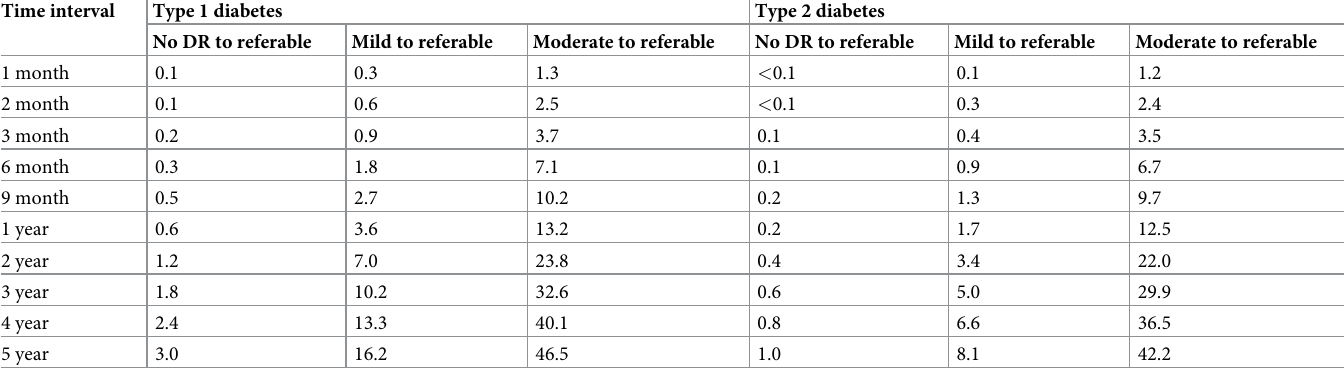
Rates of transition to referable DR predicted at different time intervals using model including penultimate 2 DR grades and patient’s age at grading, sex, diabetes duration, HbA1c, and total cholesterol (Model 5 in S3 Table). DR, diabetic